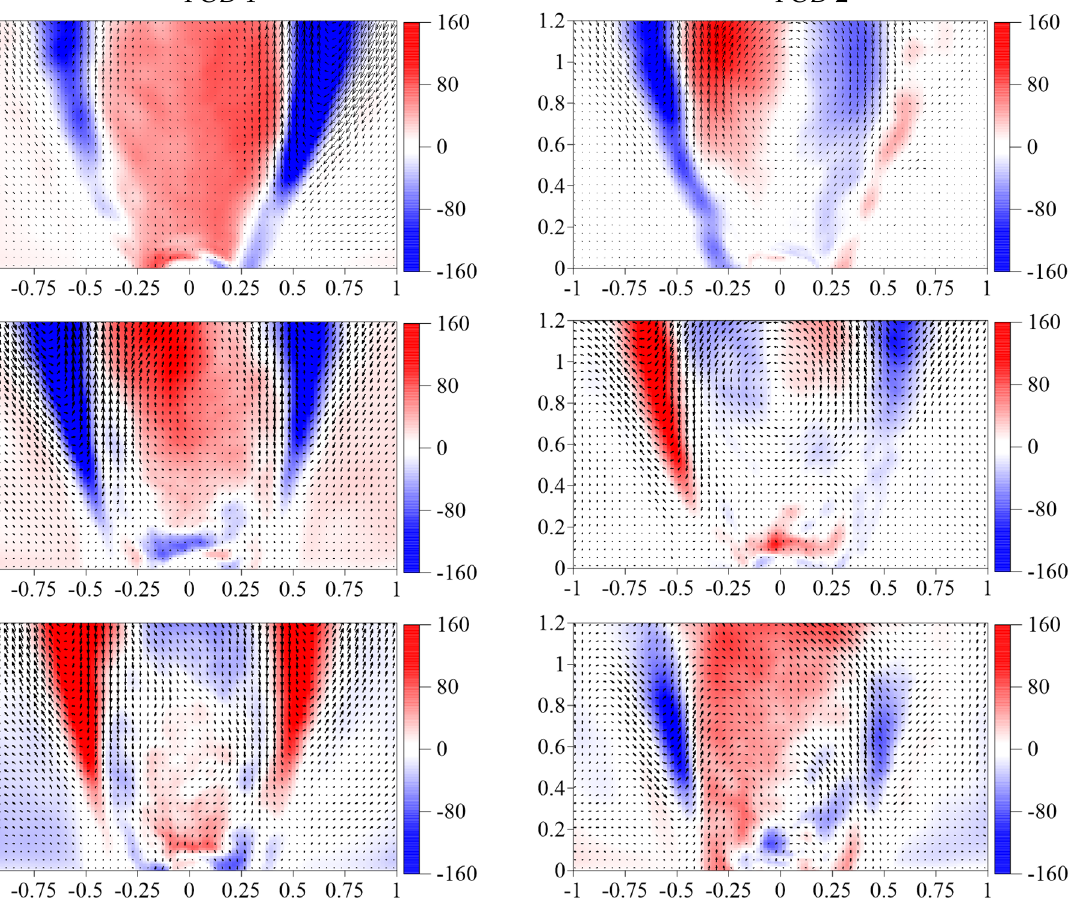
Figure 12. The first and the second POD modes with the conditional sampled temperature: the first line—1 atm. 293 K; the second line—2 atm. 500 K; the third line—3.4 atm. 500